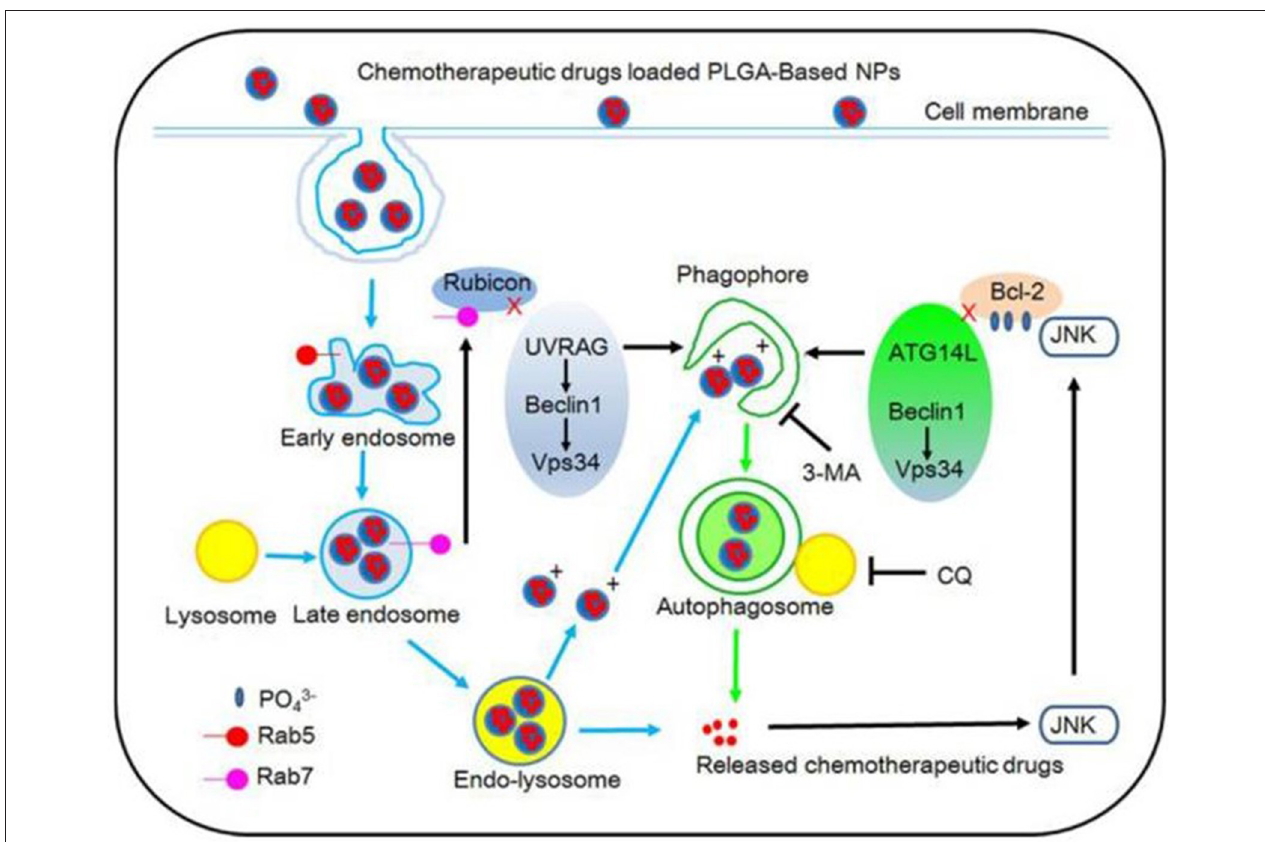
FIGURE 3 | The degradation process of PLGA-based nanoparticles is depicted schematically. Reproduced with permission (35).